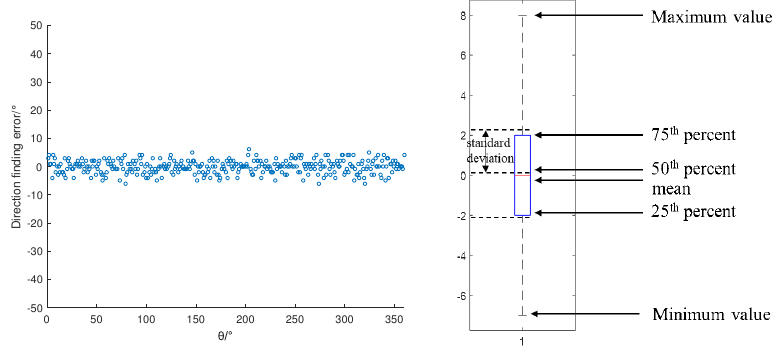
Figure 4. Direction-finding error in different directions (SNR = − 10). ( a ) Error scatter plot. ( b ) Error box